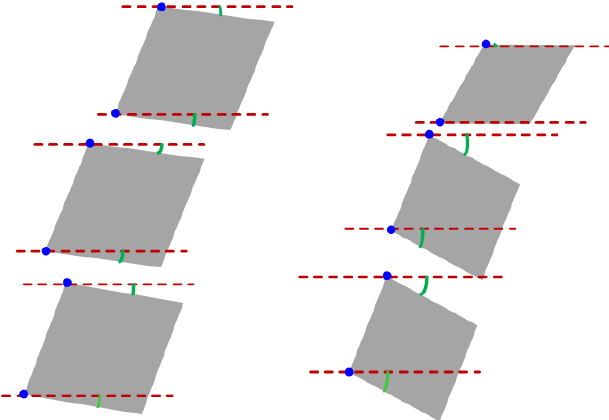
Figure 9. Examples of vertebrae with different tilt angles.